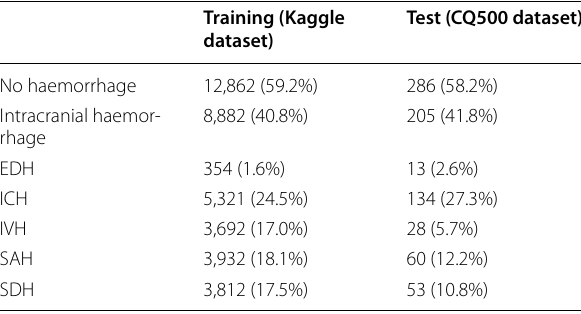
Table 1 Proportions of each class label in the Kaggle and CQ500